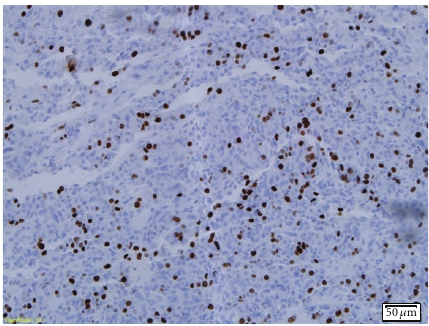
Figure3:PositiveMGMTreactionwasobservedinendothelialcells and only in single tumor cells. Activity of MGMT in tumor cells was assessed as very